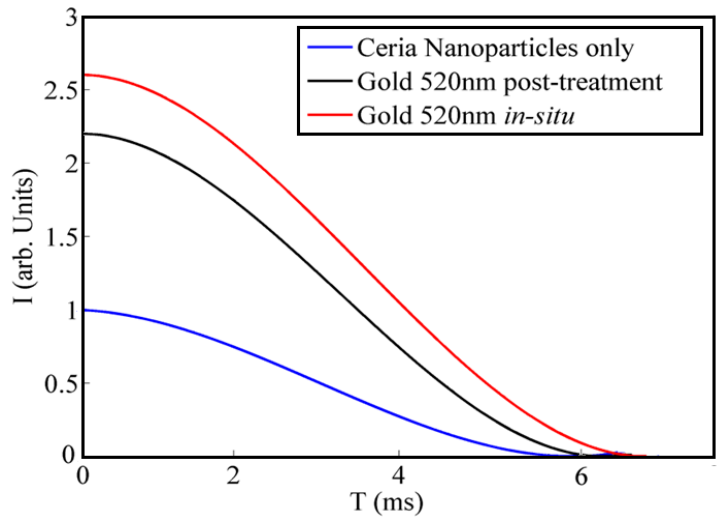
Figure 5. Fluorescence lifetime of ceria and gold-ceria nanoparticles in both cases of in-situ and post-synthesis addition.